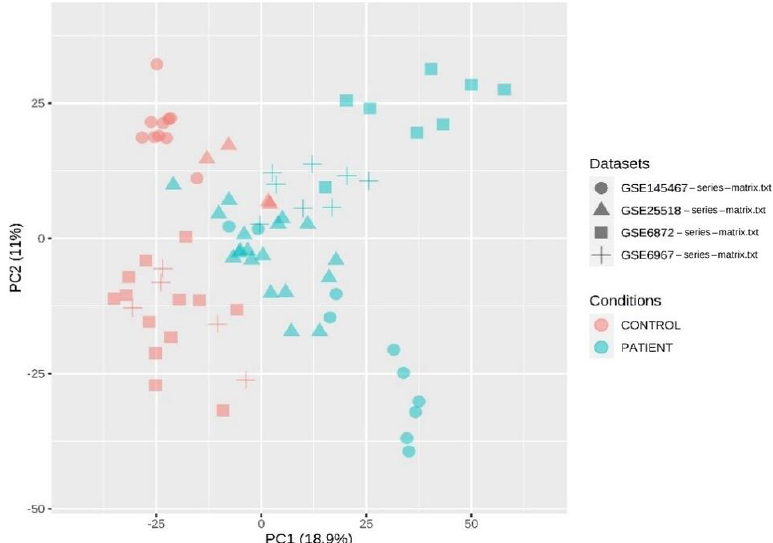
Figure 6. A two-dimensional (2D) PCA plot of the four datasets, two of teratozoospermia and two of azoospermia. In this figure, the round shape represents the dataset GSE145467, the triangular shape represents the dataset GSE25518, the square shape represents the dataset GSE6872, and the “+” symbol represents the dataset GSE6967. The pink color shows the control samples while the sky color shows the patient samples.